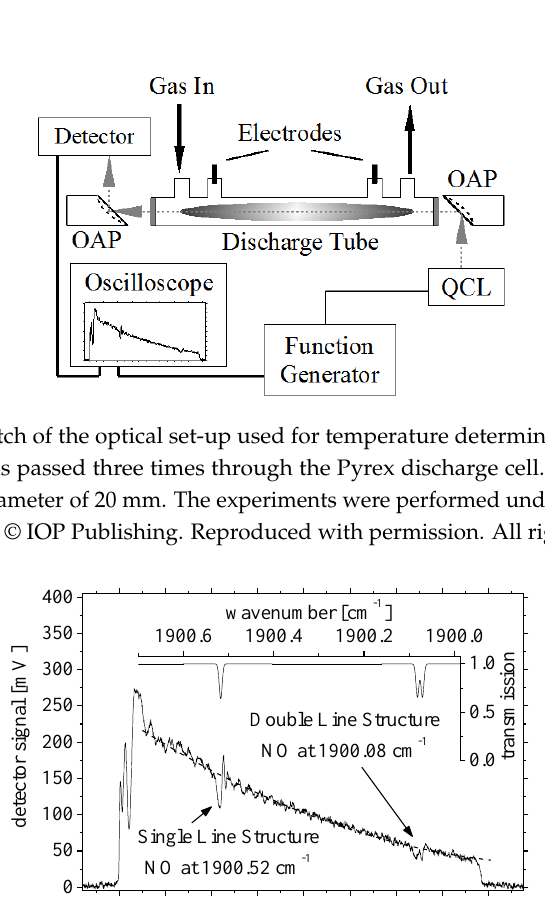
Figure 2. Detected NO spectrum in the time domain measured by the QCLAS system. The spectrum (solid line) corresponds to 0.8 % NO in air at a pressure of 1.33 mbar with an absorption length L = 180 cm. The dashed curve shows the baseline. The embedded diagram shows a simulated NO spectrum using the HITRAN database [50,83], © IOP Publishing. Reproduced with permission. All rights reserved.